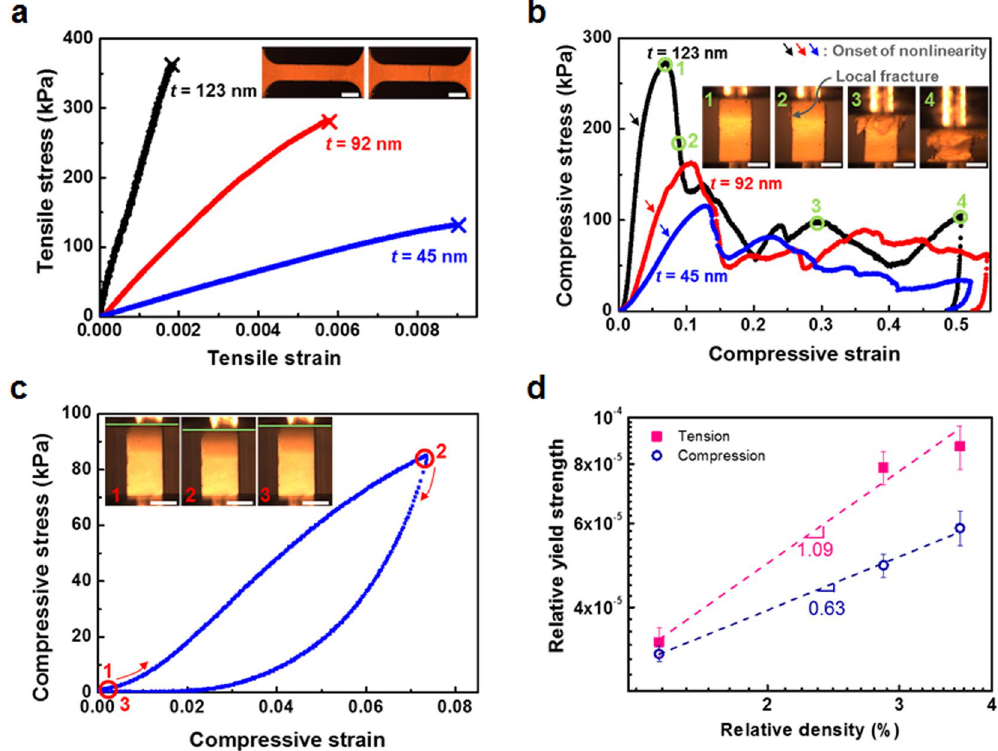
Figure 2. ( a ) Tensile behavior of nanotubular ZnO. Inset: OM images before and after micro-tensile testing (scale bars, 500 μ m). ( b ) Compressive behavior of nanotubular ZnO. Insets: OM images of compressed nanotubular ZnO at points 1 through 4 in compressive stress-strain curve for t = 123 nm (scale bars, 500 μ m). ( c ) Interrupted unloading testing for t = 45 nm. Insets: OM images of nanotubular ZnO at points 1 through 3 in stress-strain curve (scale bars, 500 μ m). ( d ) Relative yield strength, ratio of yield strength of nanotubular ZnO structure to strength of constituent ZnO measured by hole-nanoindentation, 3.9 GPa as a function of relative